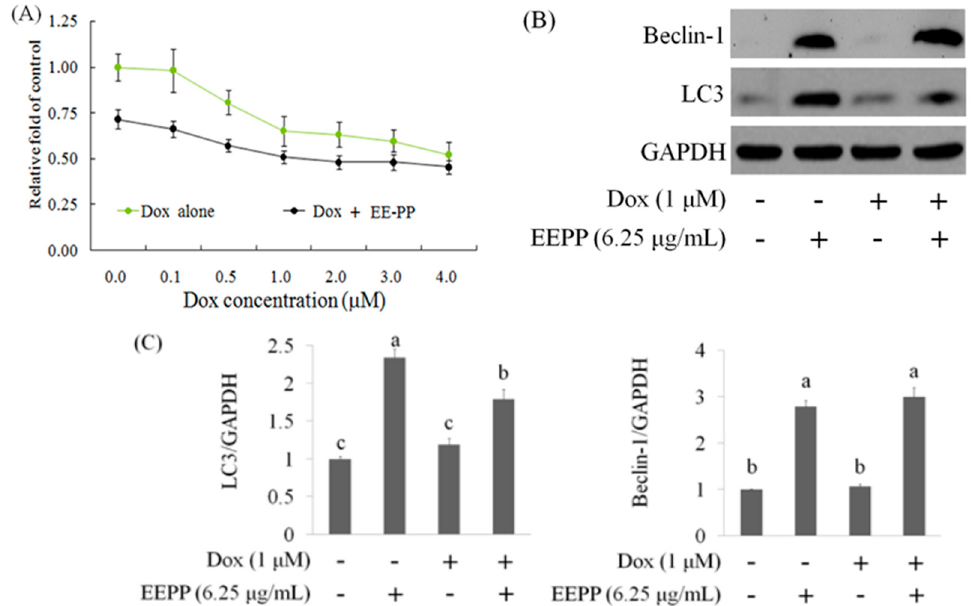
Figure 4. The combined effect of EEPP with doxorubicin ( A ). The suppressive effect of EEPP (3.13 μ g/mL) combined with doxorubicin (Dox) for 24 h in DLD-1 colorectal carcinoma cells ( B and C ). The upregulation of Beclin-1 and LC3 expressions in EEPP-treated DLD-1 carcinoma cells. Data are shown as means ± SD ( n = 3). The significant differences are denoted by diferent letters ( p < 0.05).